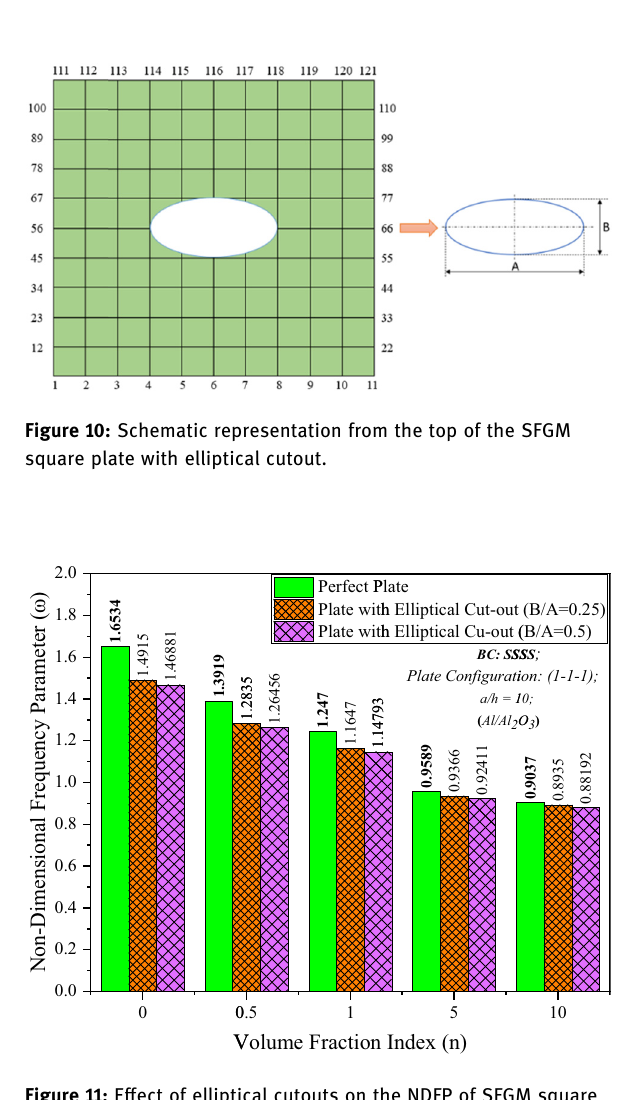
Figure 11: E ff ect of elliptical cutouts on the NDFP of SFGM square plate by varying B / A ratio under the SSSS boundary condition using ( 1 - 1 - 1 ) con fi guration.